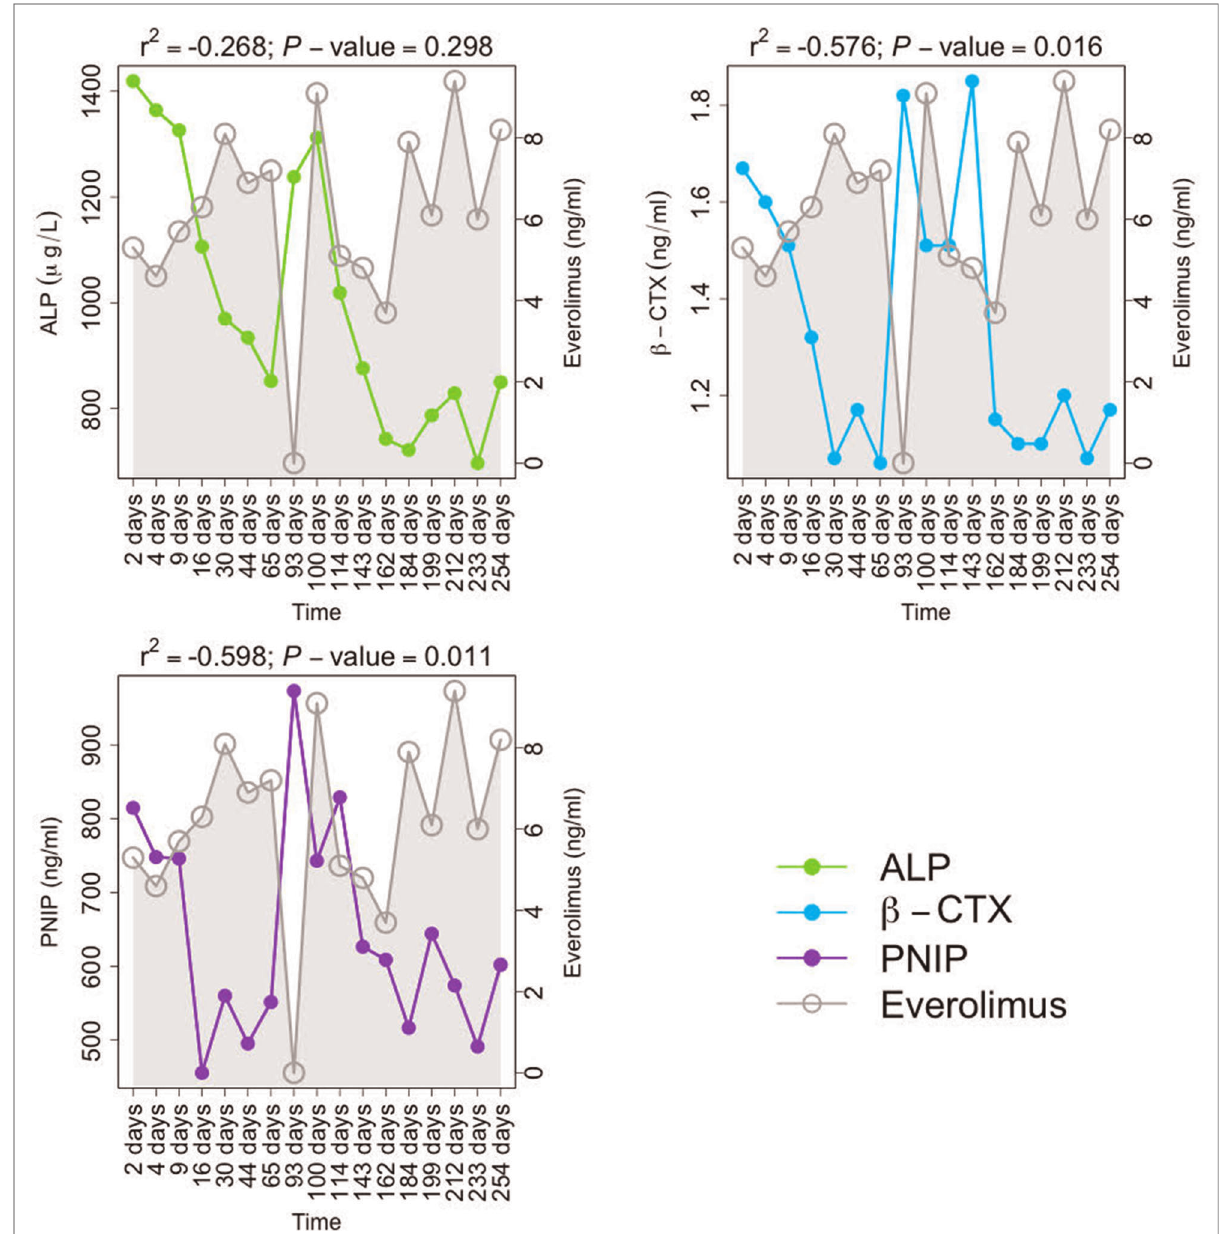
FIGURE 2 Follow-up of bone turnover activity biomarkers (BTMs) during immunosuppressive treatment with Everolimus. ALP is expressed in μ g/L; β -crosslap, PNIP, and Everolimus levels are measured in ng/ml. Pearson ’ s correlation coef fi cients between the corresponding BTM and Everolimus levels are displayed with the P